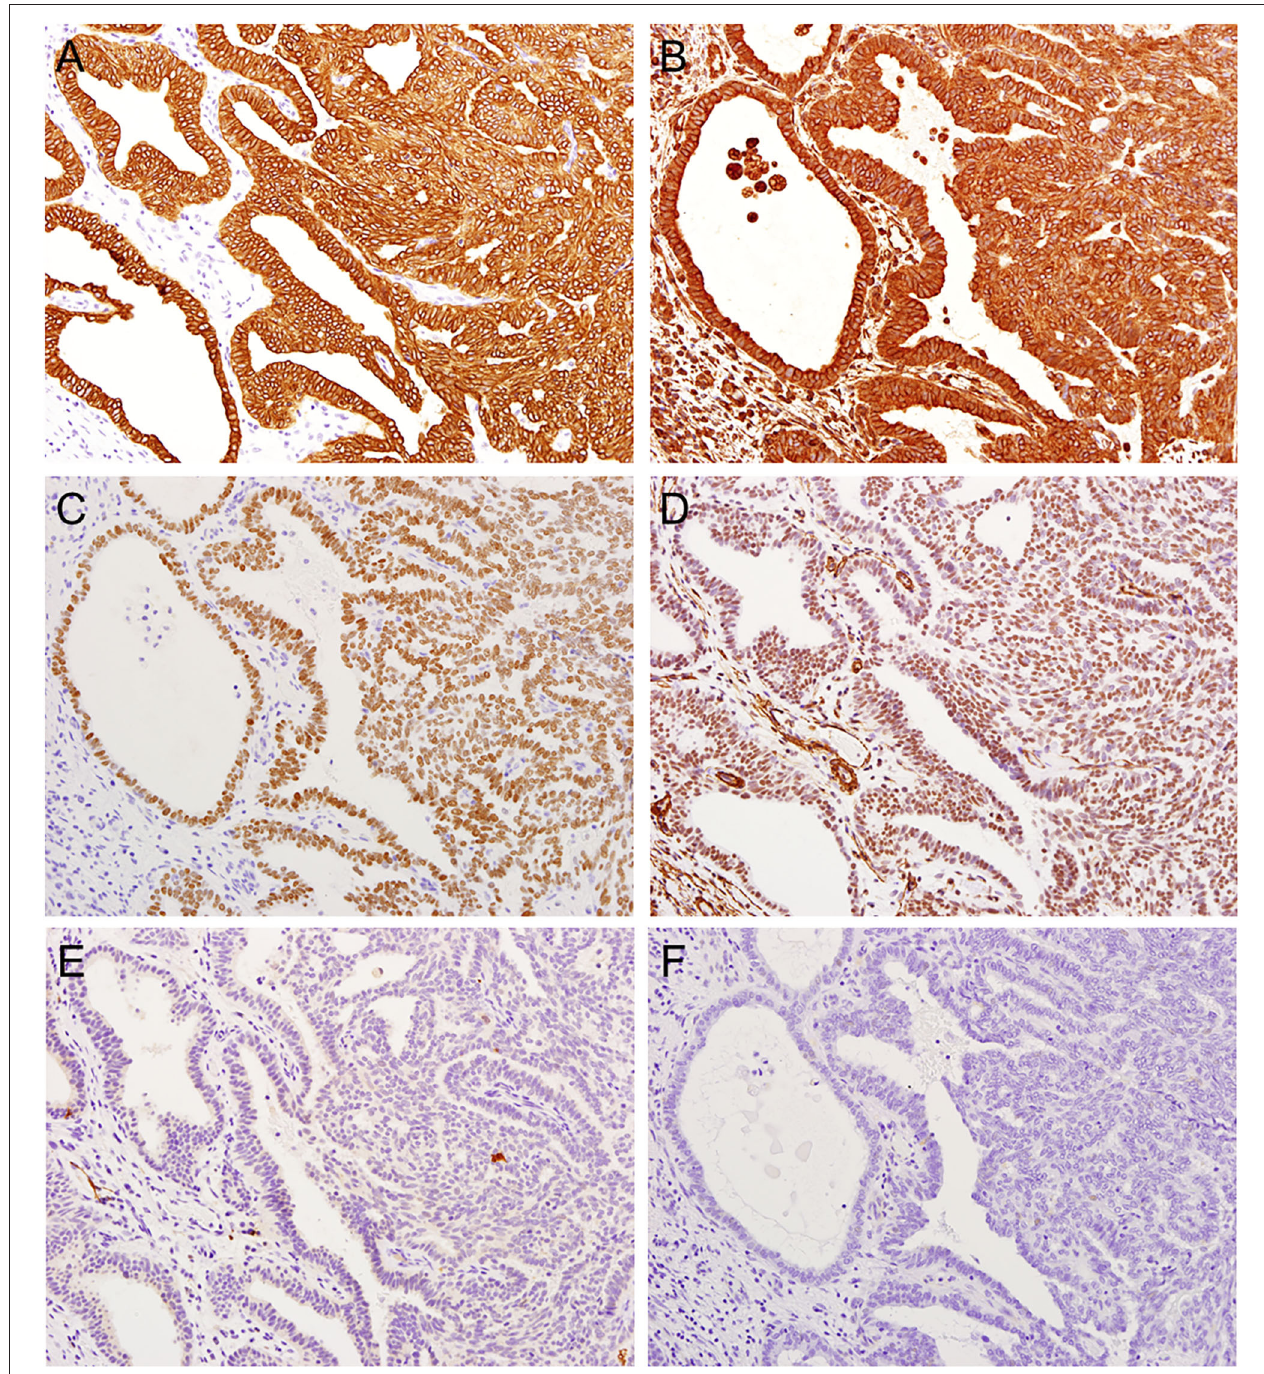
FIGURE 3 | Immunohistochemical features of TL-LGNPPA. (A) Positive staining for cytokeratin (CK) AE1/AE3 ( × 20). (B) Positive staining for vimentin ( × 20). (C) Positive nuclear staining for thyroid tissue factor-1 (TTF-1) ( × 20). (D) Negative staining for smooth muscle actin (SMA) ( × 20). (E) Negative staining for S100 ( × 20). (F) Negative staining for thyroglobulin ( ×